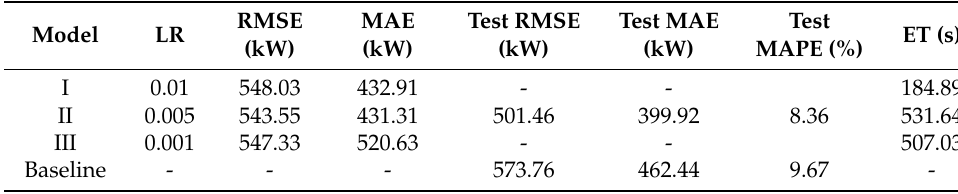
Figure 10. Twelve-hours-ahead initial forecasts.